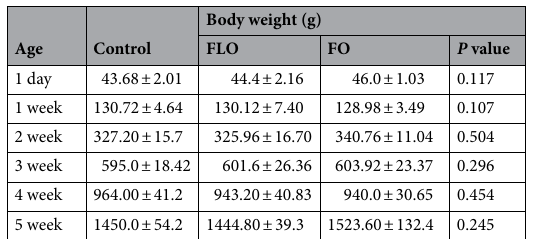
Table 1. The effect of different supplemental oils on body weight at different ages of broilers. Values are means ± SD. FLO flaxseed oil, F fish oil.